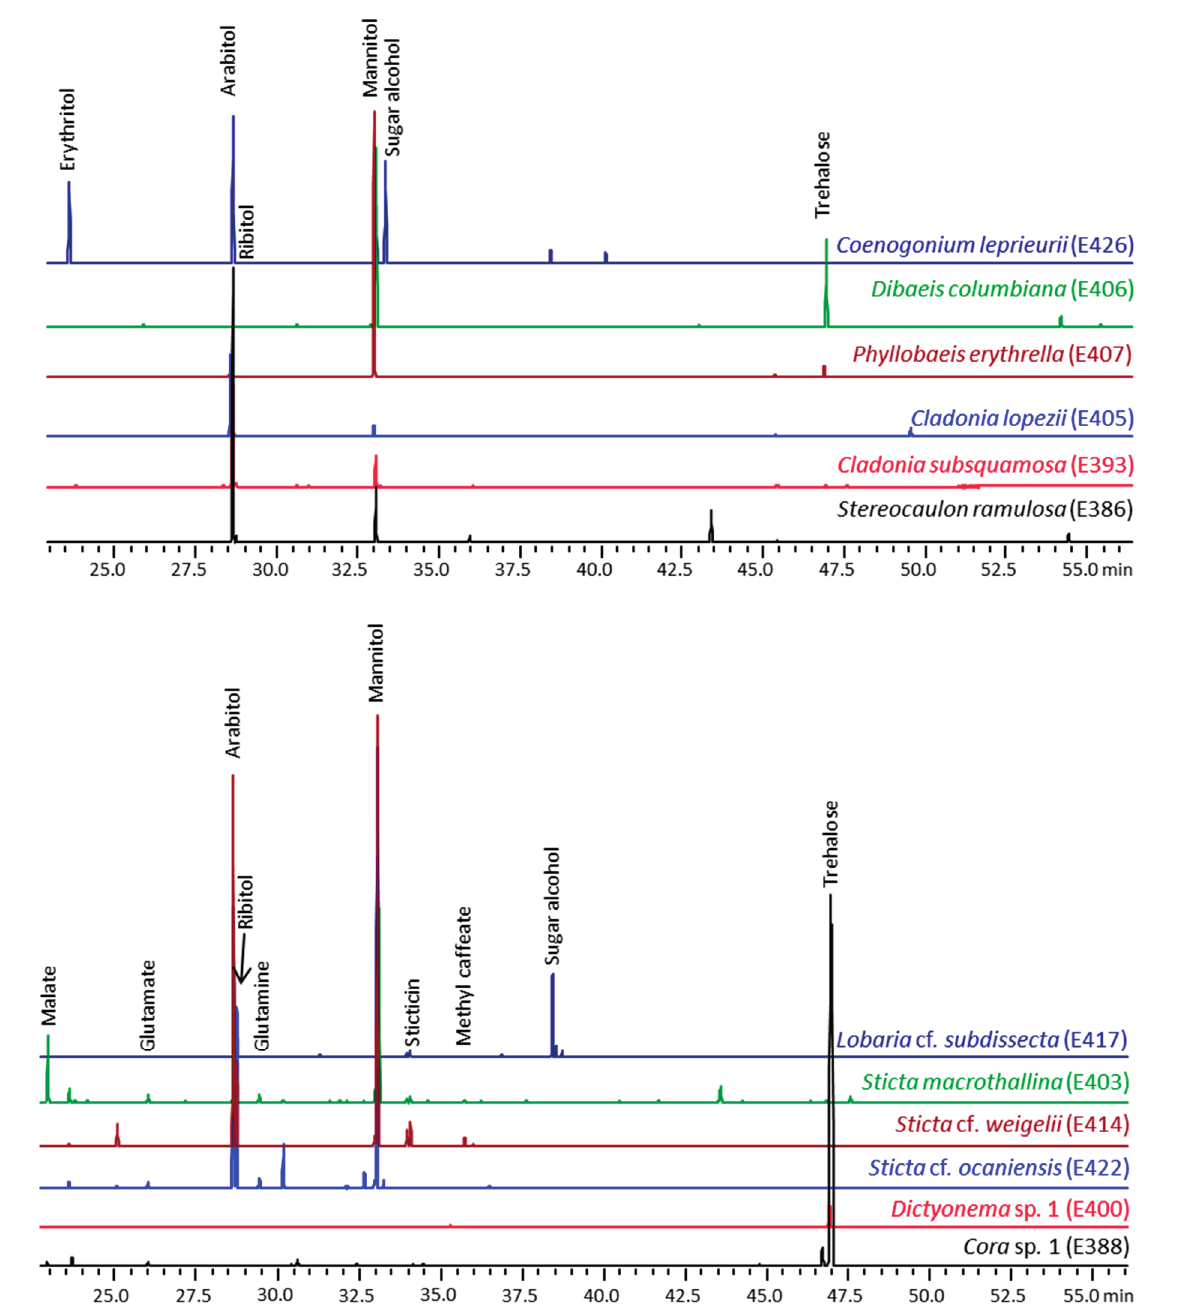
Figure 8. Detection of metabolites (as MSTFA derivatives) by GC-MS in methanolic extracts of some Ecuadorian lichens. The compounds were assigned on the basis of their specific MS patterns by comparison with reference data. The chromatograms were scaled to the peak height of the norvaline